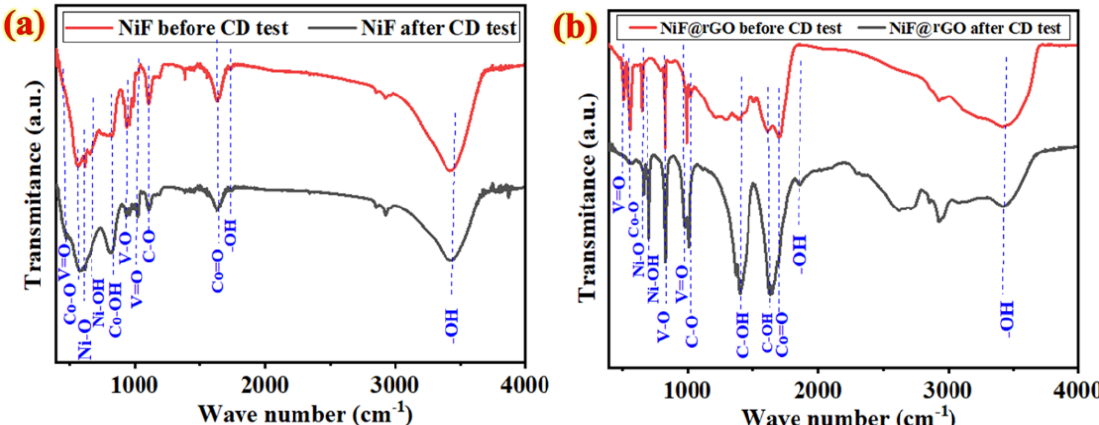
Figure 11. FTIR spectra of various samples coated on ( a ) Ni foam, ( b ) Ni foam@rGO substrate before and after electrochemical reduction.